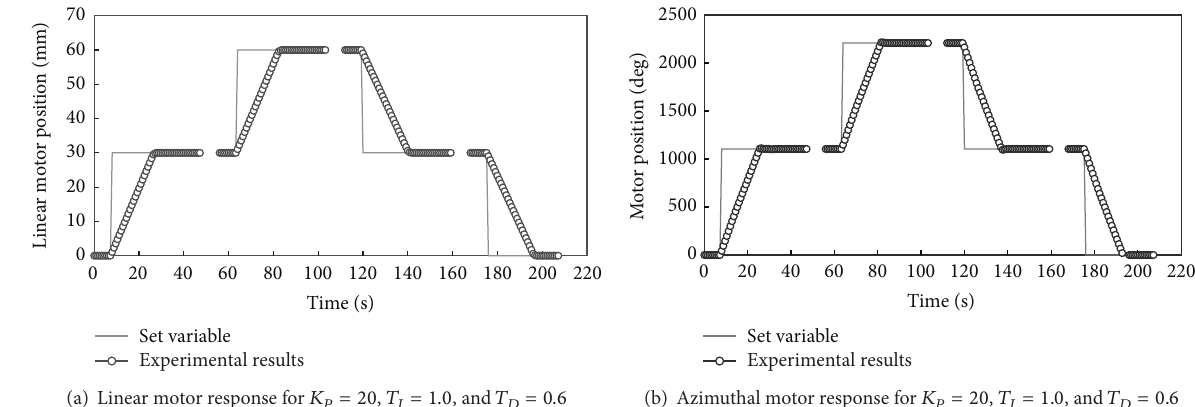
(b) Azimuthal motor response for 𝐾 𝑃 = 20 , 𝑇 𝐼 = 1.0 , and 𝑇 𝐷 = 0.6 Figure 11: Position step response of the linear and azimuth motors for medium displacements.